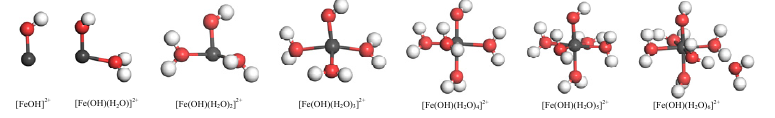
Table 1. Calculated structural parameters and energy of Fe(OH)(H 2 O) n 2+ ( n =